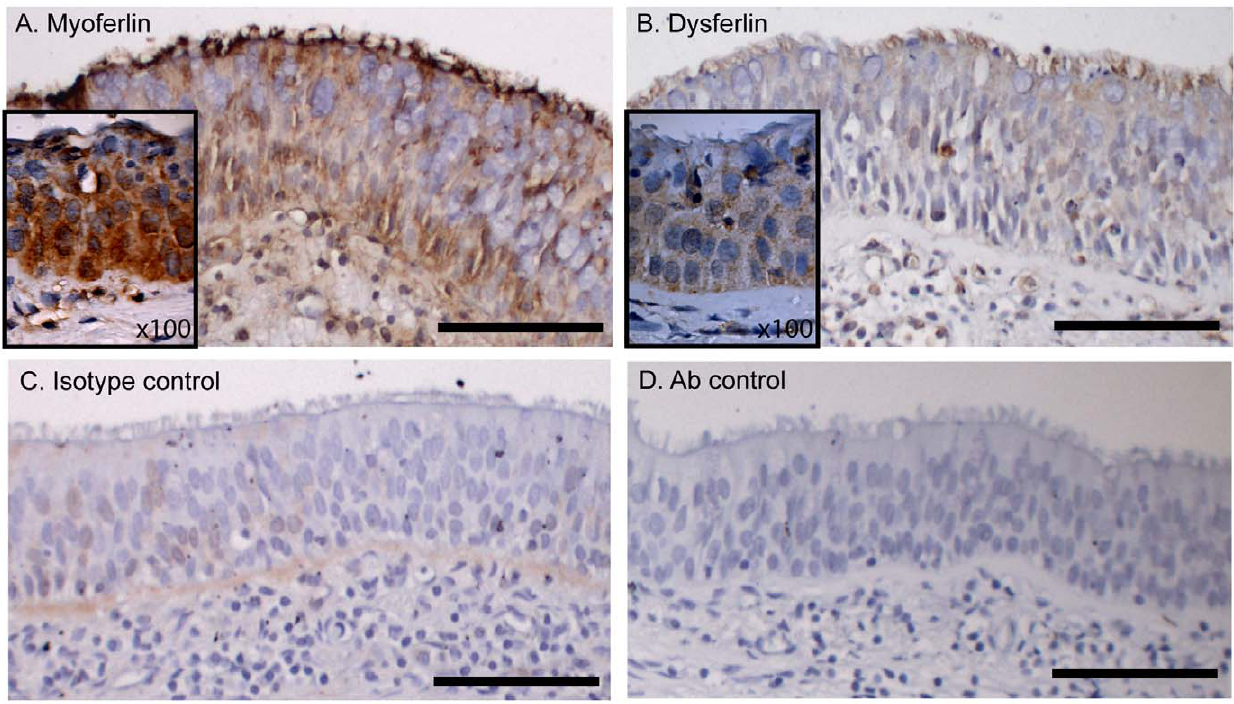
Figure 1. Dysferlin and myoferlin expression in normal human airway epithelium. Airway sections were obtained from non-diseased human subjects (n=5) and sections were stained with (A) myoferlin, (B) dysferlin, (C) isotype control and (D) secondary antibodies. The images are